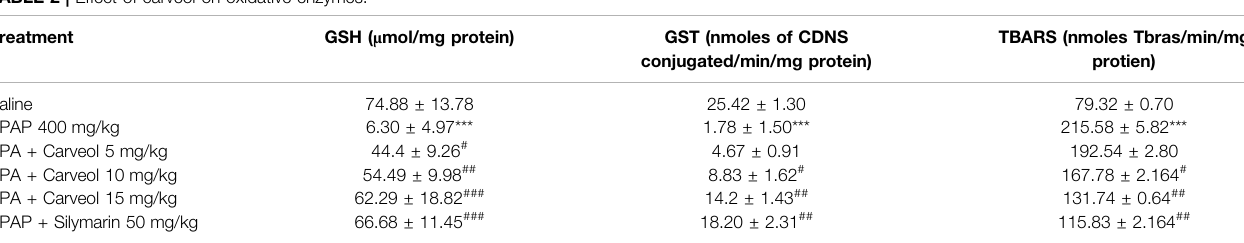
TABLE 2 | Effect of carveol on oxidative enzymes.